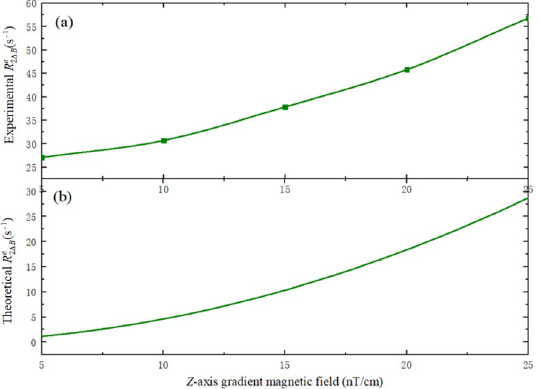
Figure 4. Experimental results of magnetic gradient relaxation of alkali metal atoms in coupled spin ensemble under applied z -axis magnetic gradient. ( a ) The experimental measurement results; ( b ) The simulation results based on the theoretical Equation (15).